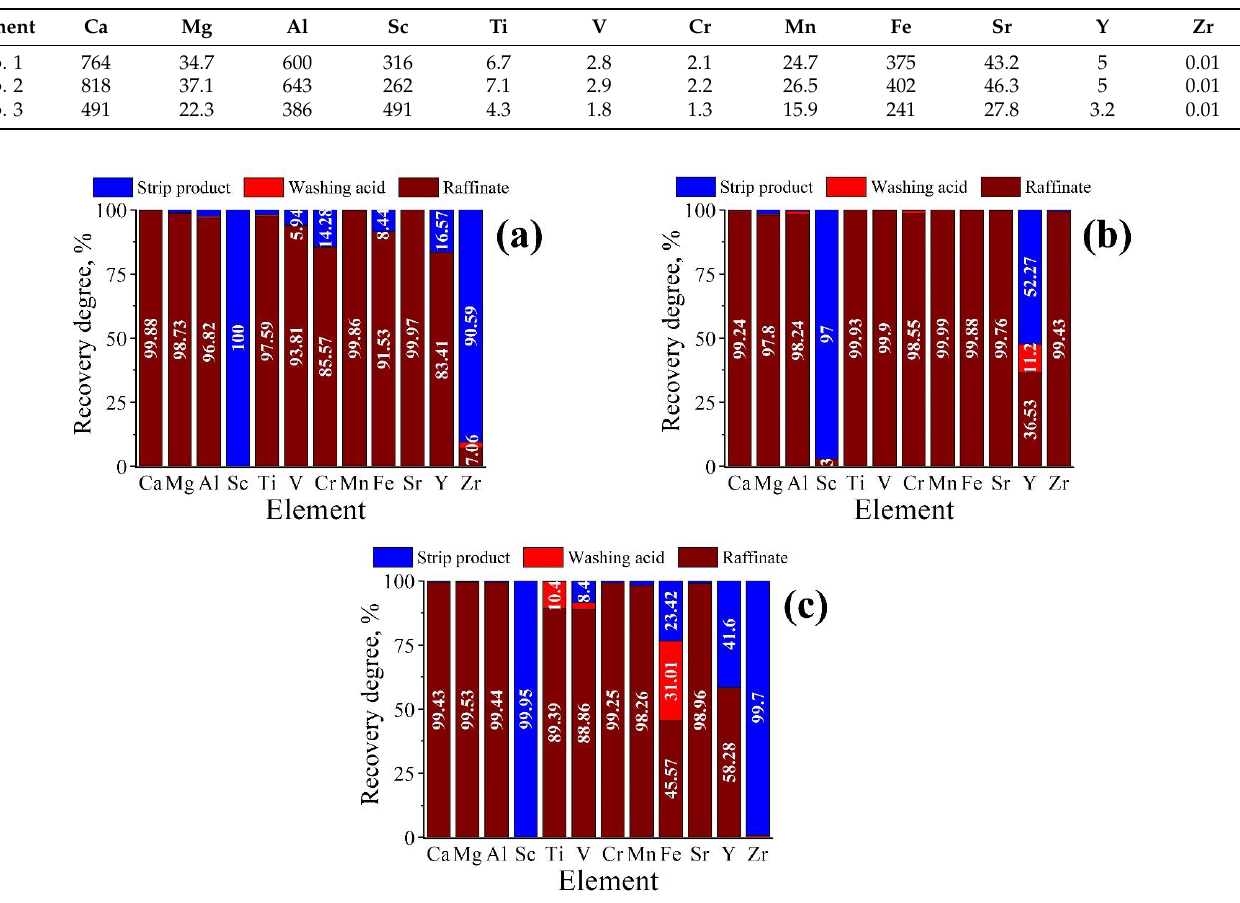
Figure 10. The recovery degree of elements from the saturated mother liquor into strip product, washing acid, and raffinate in experiments 1 ( a ), 2 ( b ), and 3 ( c ). As follows from the bar chart, almost full Sc recovery was in all the experiments. The best result is 99.95% Sc in the strip product in experiment 3. Yttrium and zirconium be- havior are proved to be similar to scandium, but insignificant values of the Y and Zr re- covery degree in the strip product in some experiments are probably due to their low content in the initial solution. A satisfactory separation of Fe and Ti is due to the prior preparation, namely, iron (III) reduction to iron (II) and titanium complexing in [TiO(H 2 O 2 )] 2+ , which is poorly soluble in the organic phase.